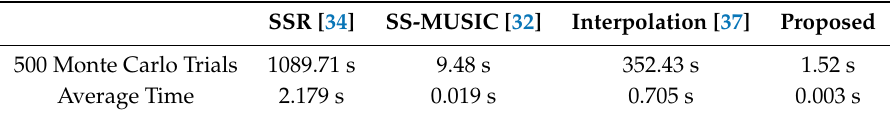
Figure 7. Resolution probability comparison of each algorithm with SNR = 0 dB and L = 500. Table 2. Computation time comparison of each